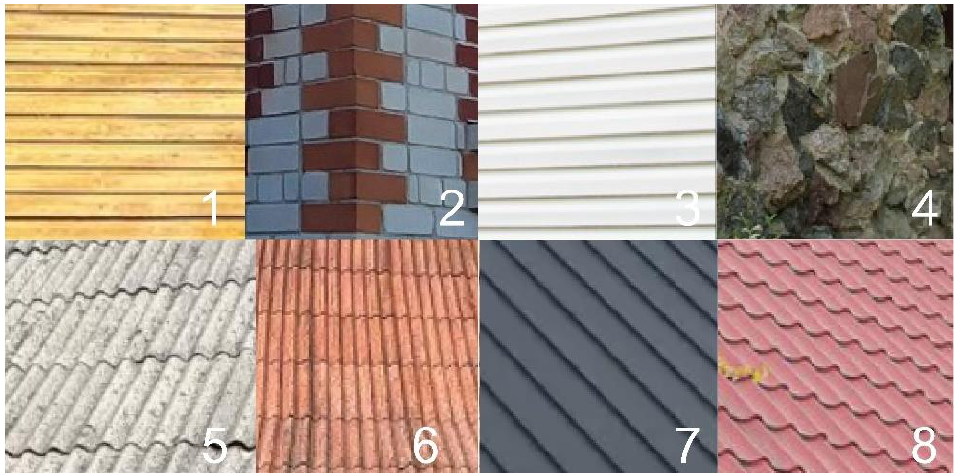
Figure 14. Building materials of garden houses: 1 — wooden cladding, 2 — bricks, 3 — plastic boards, 4 — field stones, 5 — gray asbestos panels, 6 — pink asbestos panels, 7 — rolled tin, 8 — steel sheets. Photos by A. Gabrėnas .